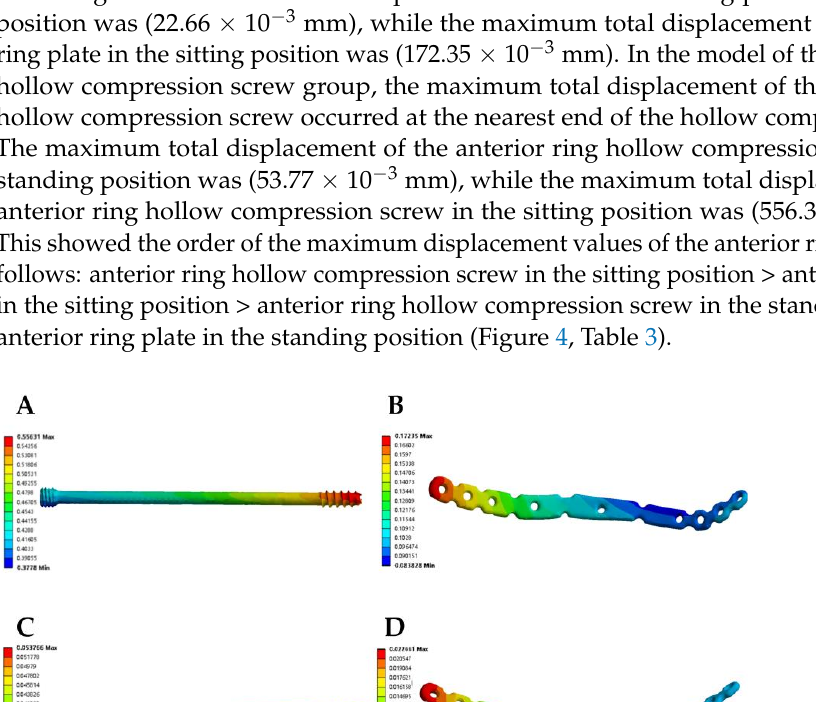
Figure 5 . Von Mises stress distribution of pelvic models fixed with different implants in standing position. ( A ) Anterior ring plate. ( B ) Anterior ring hollow screw. Von Mises stress distribution of